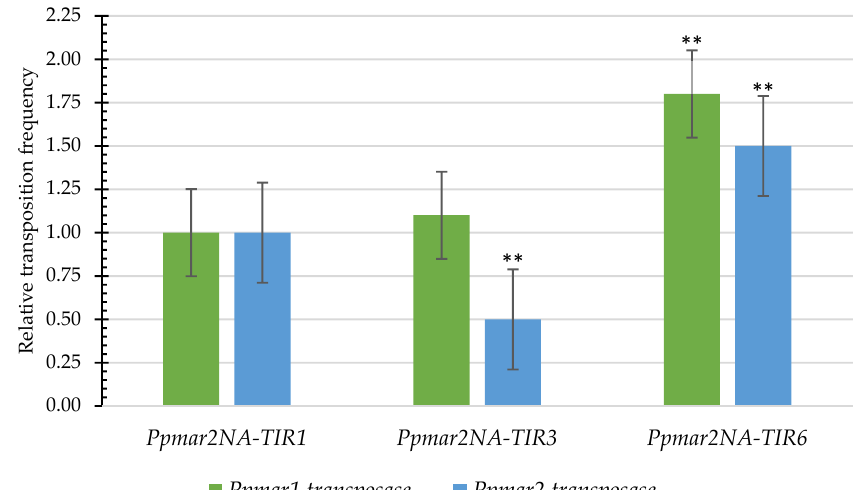
Figure 5. Relative transposition frequencies of mutated Ppmar2NA -TIRs triggered by Ppmar1 and Ppmar2 transposases. The Y-axis indicates the ratio of the mean excision frequency of six independent experiments with Ppmar2NA mutants, to that of the wild type Ppmar2NA -TIR1. The symbol ** indicates a statistically significant ( p < 0.01) difference with the wild type Ppmar2NA -TIR1. Error bars indicate standard errors.